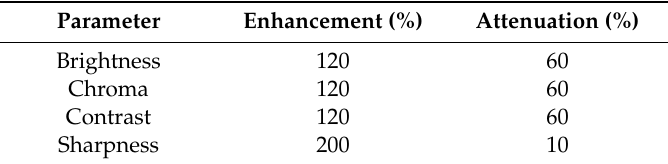
Table 2. Parameter